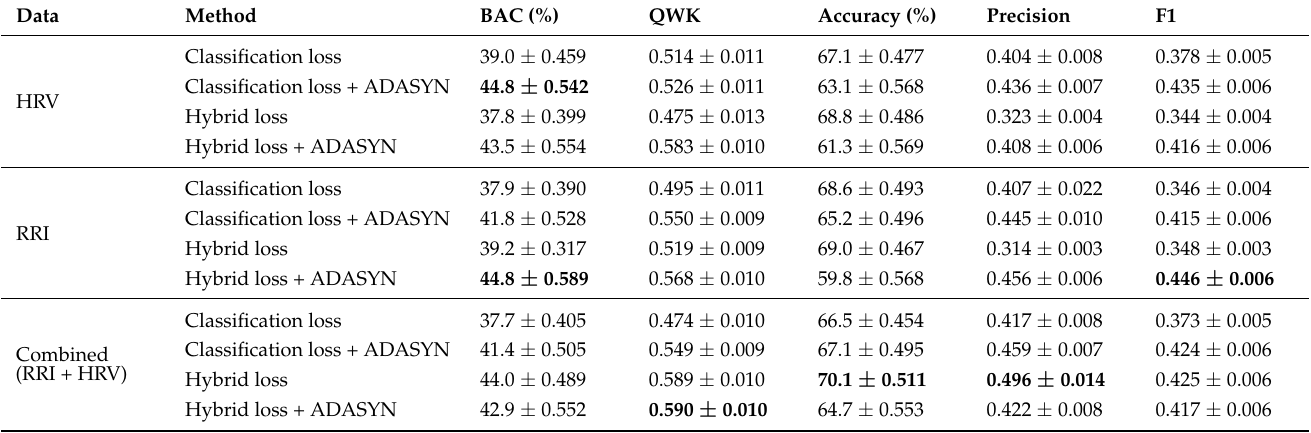
Table 6. Mean and 95% CI of the prediction performance based on the data type and method. The bold entries indicate the best performance in terms of each evaluation